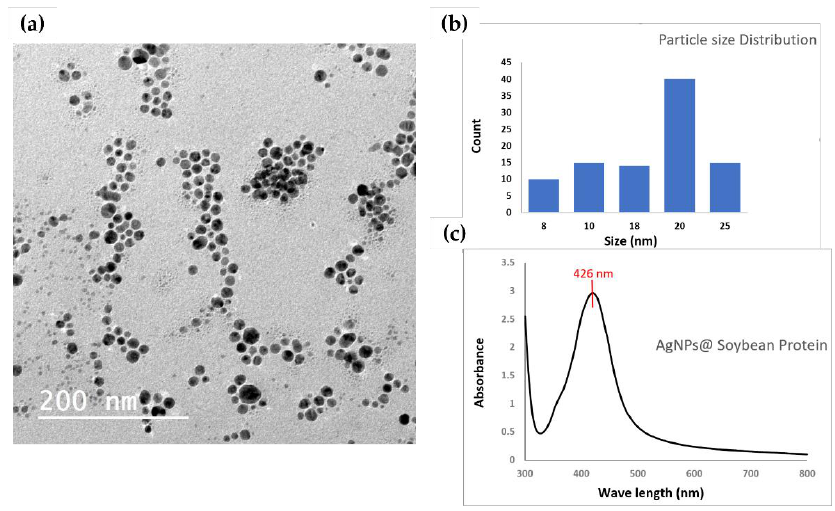
Figure 3. Characterization of silver nanoparticles, ( a ) transmission electron microscope image, ( b ) particle size distribution calculated from TEM image, and ( c ) surface plasmon resonance of AgNPs using UV-Vis spectrophotometer.